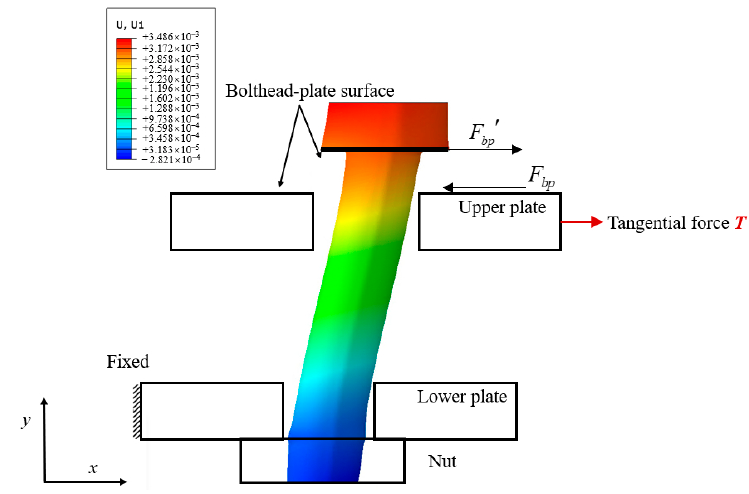
Figure 24. The displacement of the bolt in the x -direction.